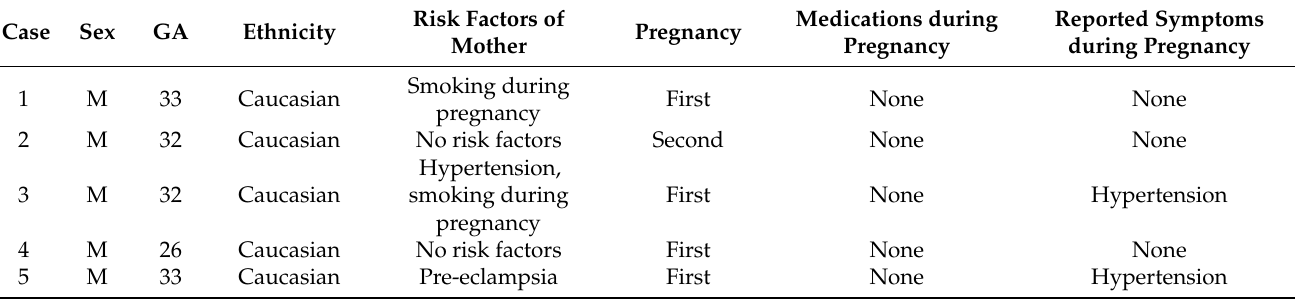
Table 1. Clinical